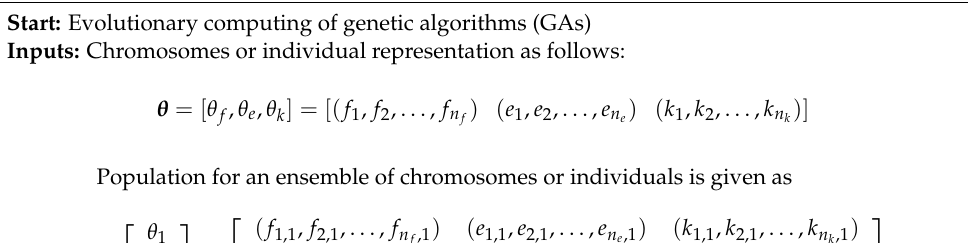
Algorithm 1: Pseudocode of evolutionary computing with GAs for HC-AR system